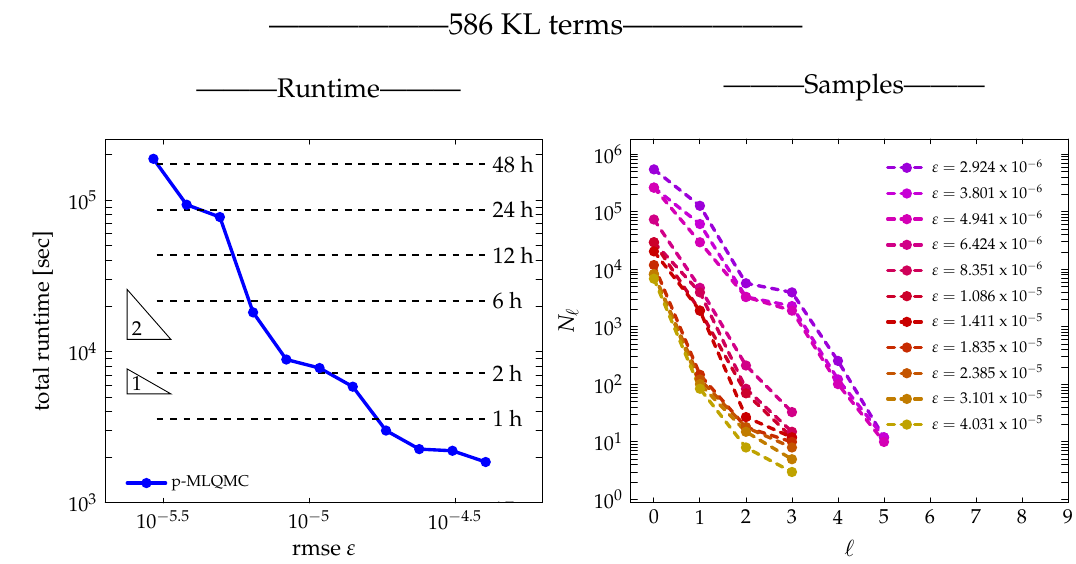
Figure 21. Runtime and sample sizes for a high stochastic dimension for model problem